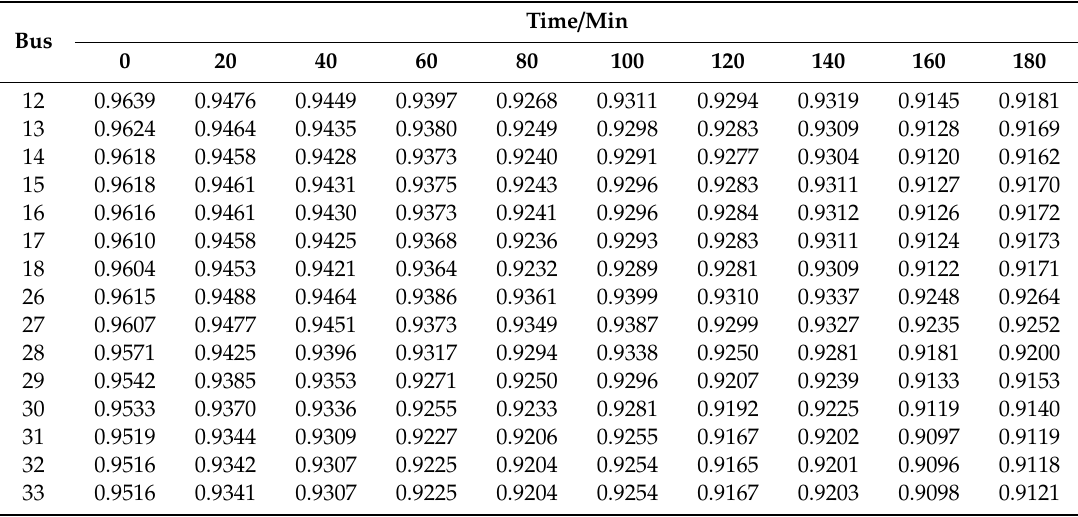
Table 2. Bus voltage fluctuations in ARs 3 and 5.